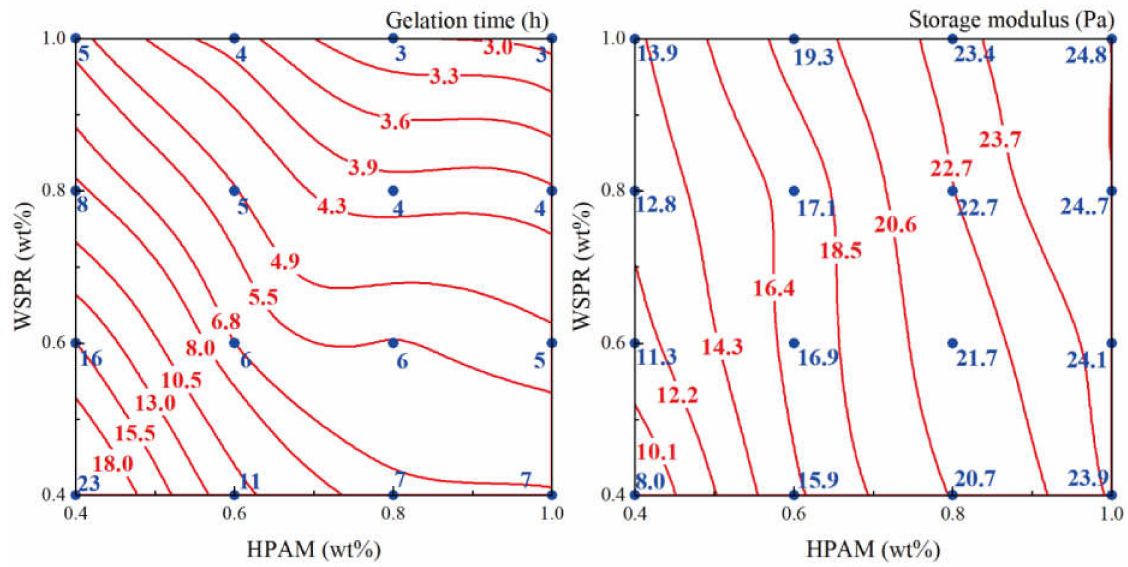
Figure 3. Gelation time and gel strength (storage modulus) of phenolic resin gel at 110 ◦ C. The results showed that the gel prepared by crosslinking HPAM with WSPR had a gelation time of between 3 and 23 h and a gel storage modulus of 8–25 Pa. When the concentration of both HPAM and WSPR in the gel was greater than 0.5 wt%, their storage modulus was greater than 10 Pa, and representing high-strength gels. The storage modulus and dehydration ratio of the above gel at 10 and 180 days of aging at 110 ◦ C are shown in Figures 4 and 5, respectively (red line and red numbers are fitted values; blue dots and blue numbers are measured values).